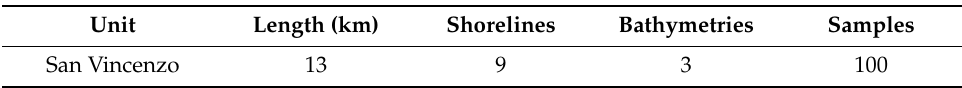
Table 1. Test site